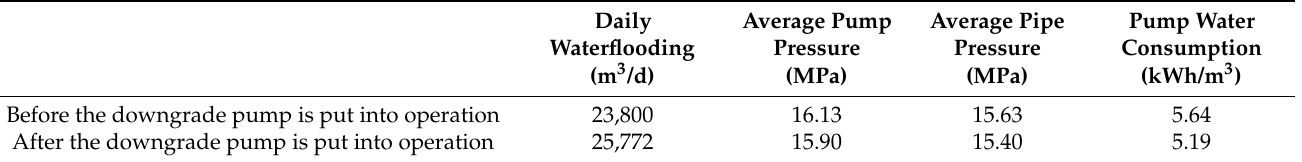
Table 5. Energy consumption of the high-pressure area before and after different pressure in the X